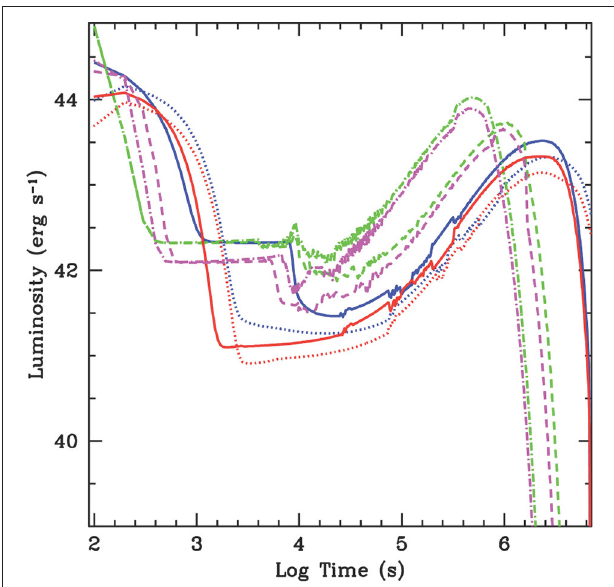
FIGURE 3 | X-ray (black), 115–180nm (magenta), 200–350nm (blue), and V-band (cyan) early luminosities as a function of time for two SN explosions whose only difference lie in their radii: 10 12 cm (dotted), 10 13 cm (solid). ATO would easily capture this early emission and not only distinguish different radii, but pin down breakout temperatures, which are important for understanding the entire lightcurve. TABLE 2 | ATO CCSNe SBO over 5